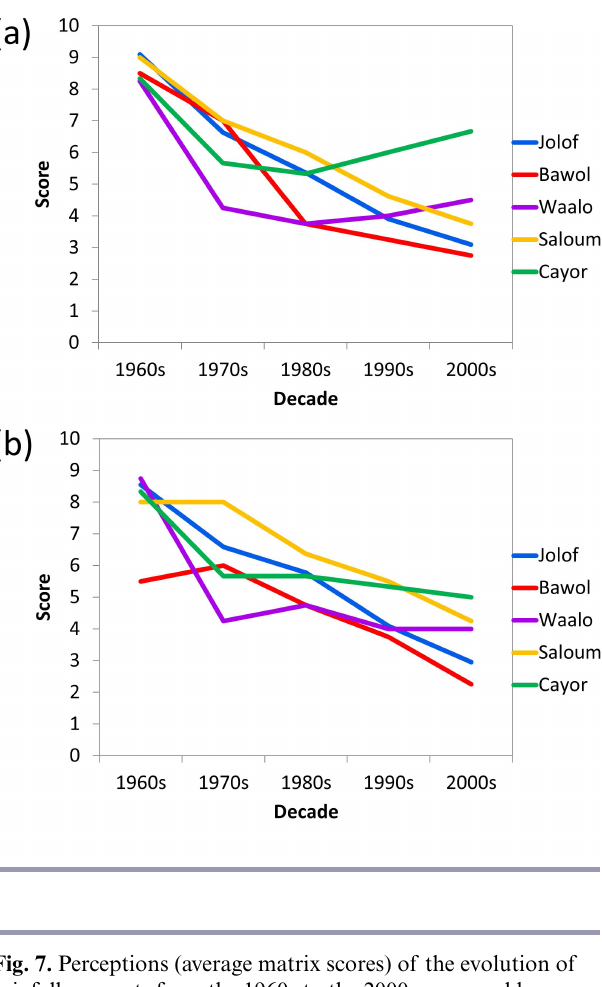
Fig. 6. Perceptions (average matrix scores) of the evolution of tree densities (a) and pasture quality (b) from the 1960s to the 2000s, averaged by region.